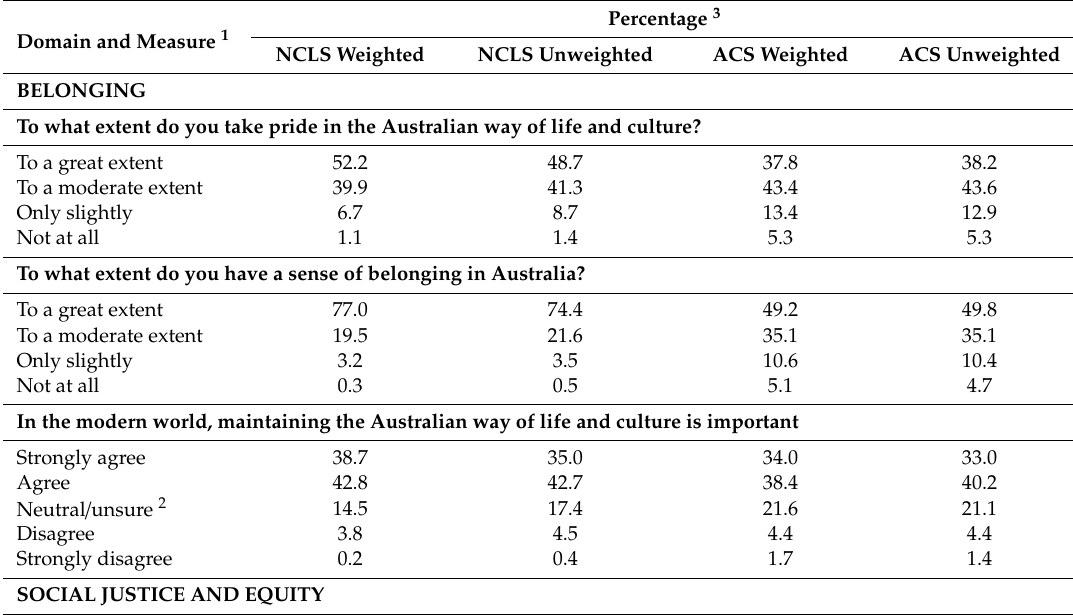
Table A2. Item wordings and results for social cohesion domains, NCLS and ACS (weighted and